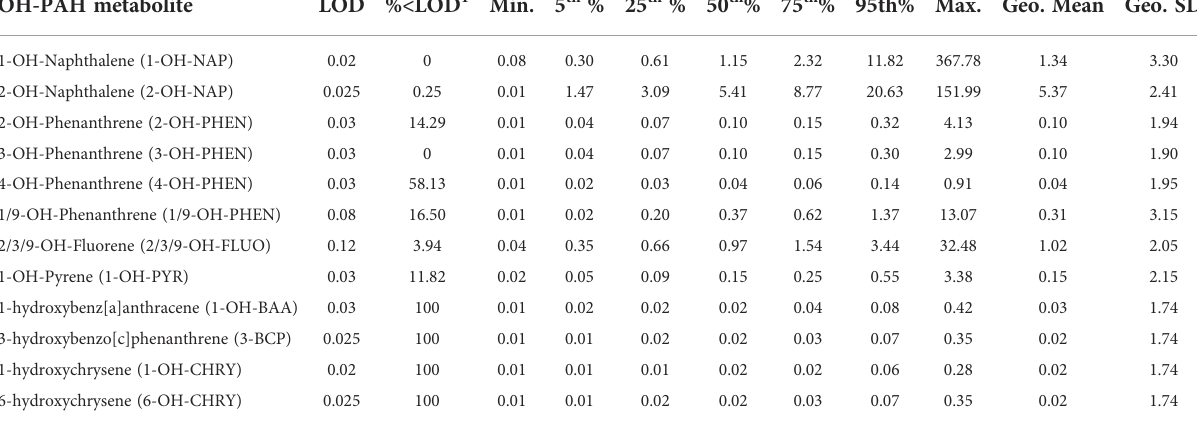
TABLE 2 Maternal urinary PAH metabolites at Visit 1 in ng/mL (n=812). OH-PAH